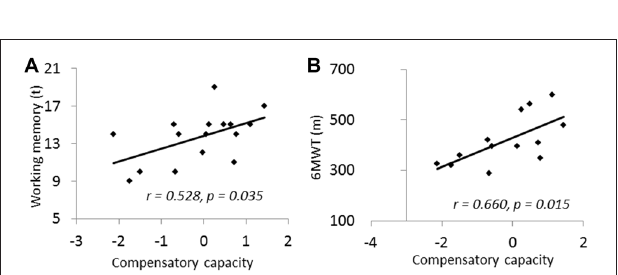
FIGURE 3 | (A) Compensatory capacity showed positive correlation to working memory. (B) Compensatory capacity showed positive correlation to 6-min walking test (6MWT). Compensatory capacity was measured by number of activated networks controlled for the GM volumes in core networks. p = 0.001 ( r = 0.2383), p = 0.005 ( r = 0.2040) and p = 0.01